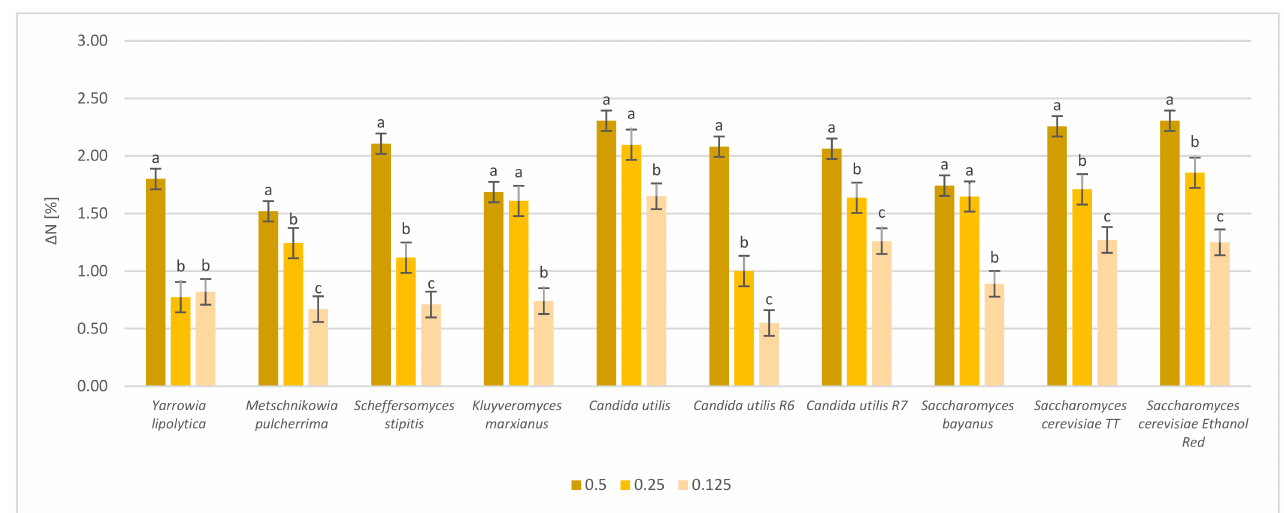
Figure 2. Protein content increase, expressed as ∆ N [%], after cultivation of fresh sugar beet pulp with selected yeast strains. The fresh biomass was hydrolyzed with various enzyme doses (0.5 mL/10 g DM; 0.25 mL/10 g DM; 0.125 mL/10 g DM). The results were adjusted to exclude the influence of enzyme preparations. a, b, c—indicators of statistically significant difference, mean values for strain with different letters are significantly different ( p <